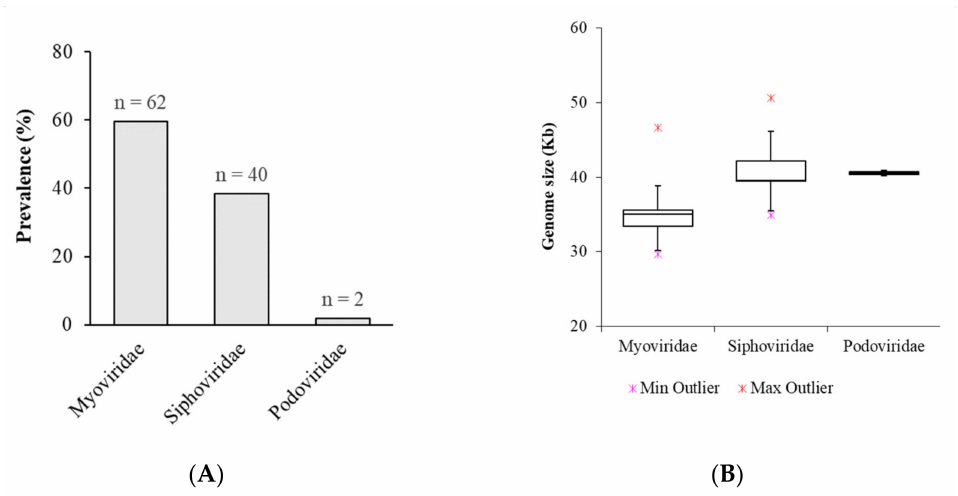
Figure 2. Distribution of 104 intact prophages integrating K. pneumoniae genomes by in silico determined family. ( A ) Prevalence of prophages in K. pneumoniae genomes by family. ( B ) Box plot of average genome size of prophages according to